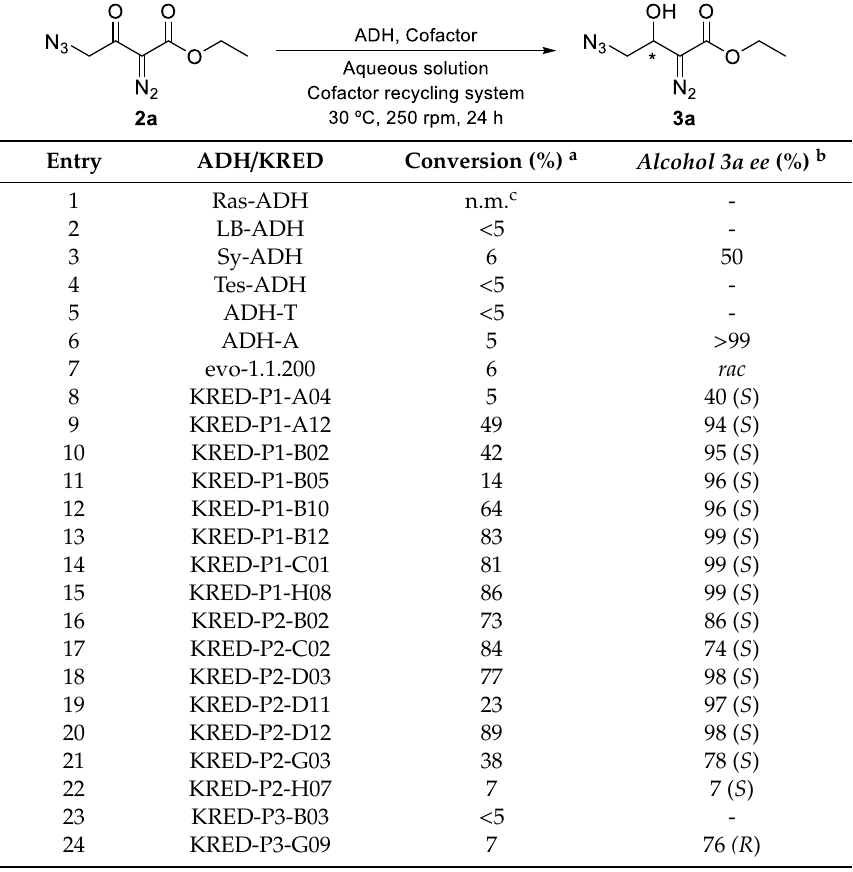
Table 2. Bioreduction of ethyl 4-azido-2-diazo-3-oxobutanoate ( 2a ) using different ADHs.